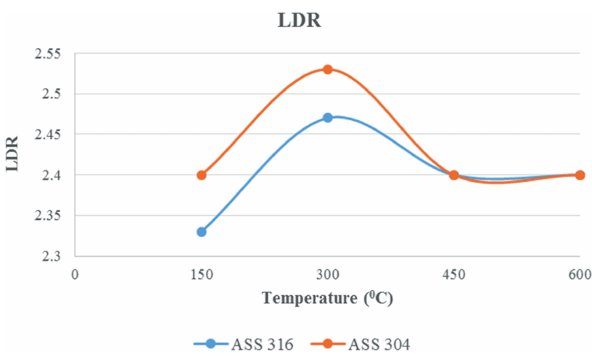
Figure 15: LDR variation with respect to